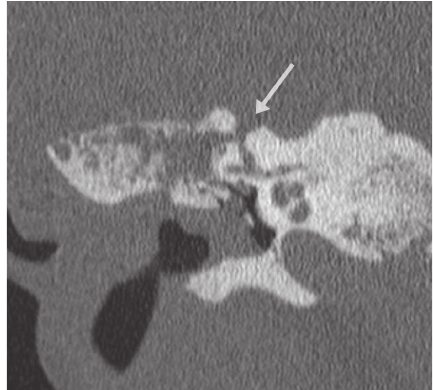
Figure 4: CT imaging of the patient in Case 2. Coronal section demonstrates a right temporal bone fracture (arrow) traversing the bony superior semicircular canal.